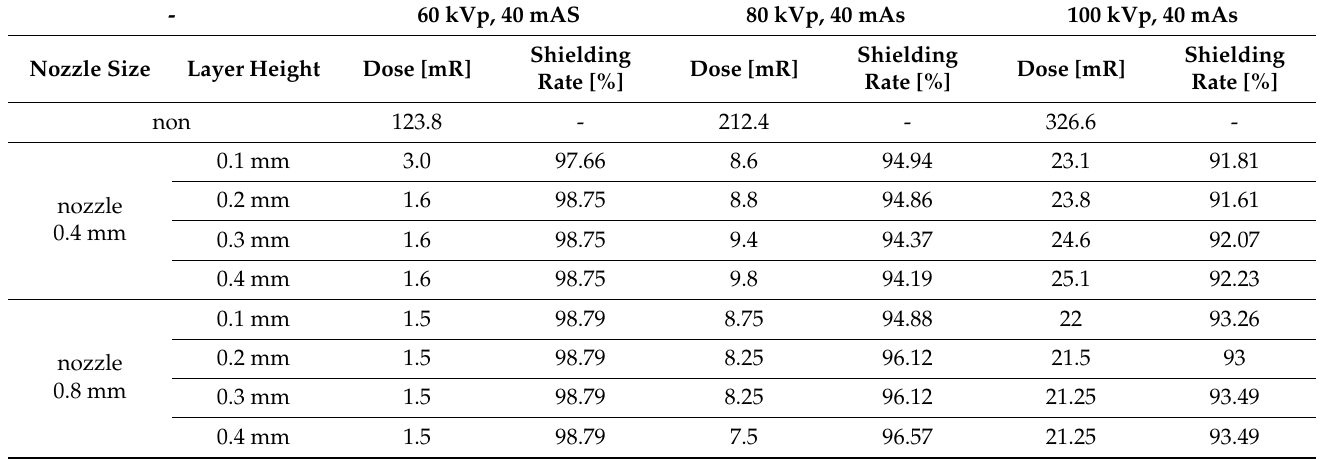
Table 3. Results of radiation shielding sheet tests.